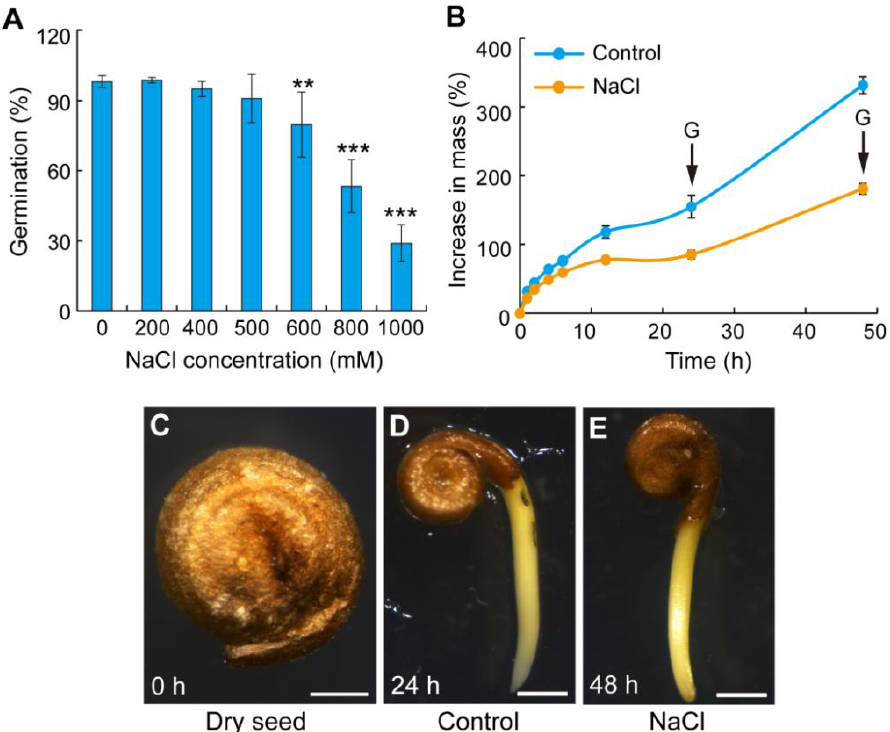
Figure 1. Identification of salinity concentration and seed morphology during brown seed germination in S. liaotungensis . ( A ) Seed germination rate under the control condition (distilled water) and different NaCl concentration treatment. Seed germination rates were calculated for 10 d. Values presented are the means ± SD for four independent experiments ( n = 40 seeds for each treatment). Significant differences were analyzed using one-way ANOVA followed by LSD test (** p < 0.01; *** p < 0.001). ( B ) Imbibition curves for brown seeds of S. liaotungensis under the control condition and 500 mM NaCl treatment. Values presented are the means ± SD for four independent experiments ( n = 30 seeds for each treatment). “G”, concentrated germination time. ( C – E ) Phenotypes of dry seeds, germinated seeds under the control (24 h) and 500 mM NaCl (48 h) treatment. Bars = 0.5 mm in ( C ) and 1 mm in ( D , E ).